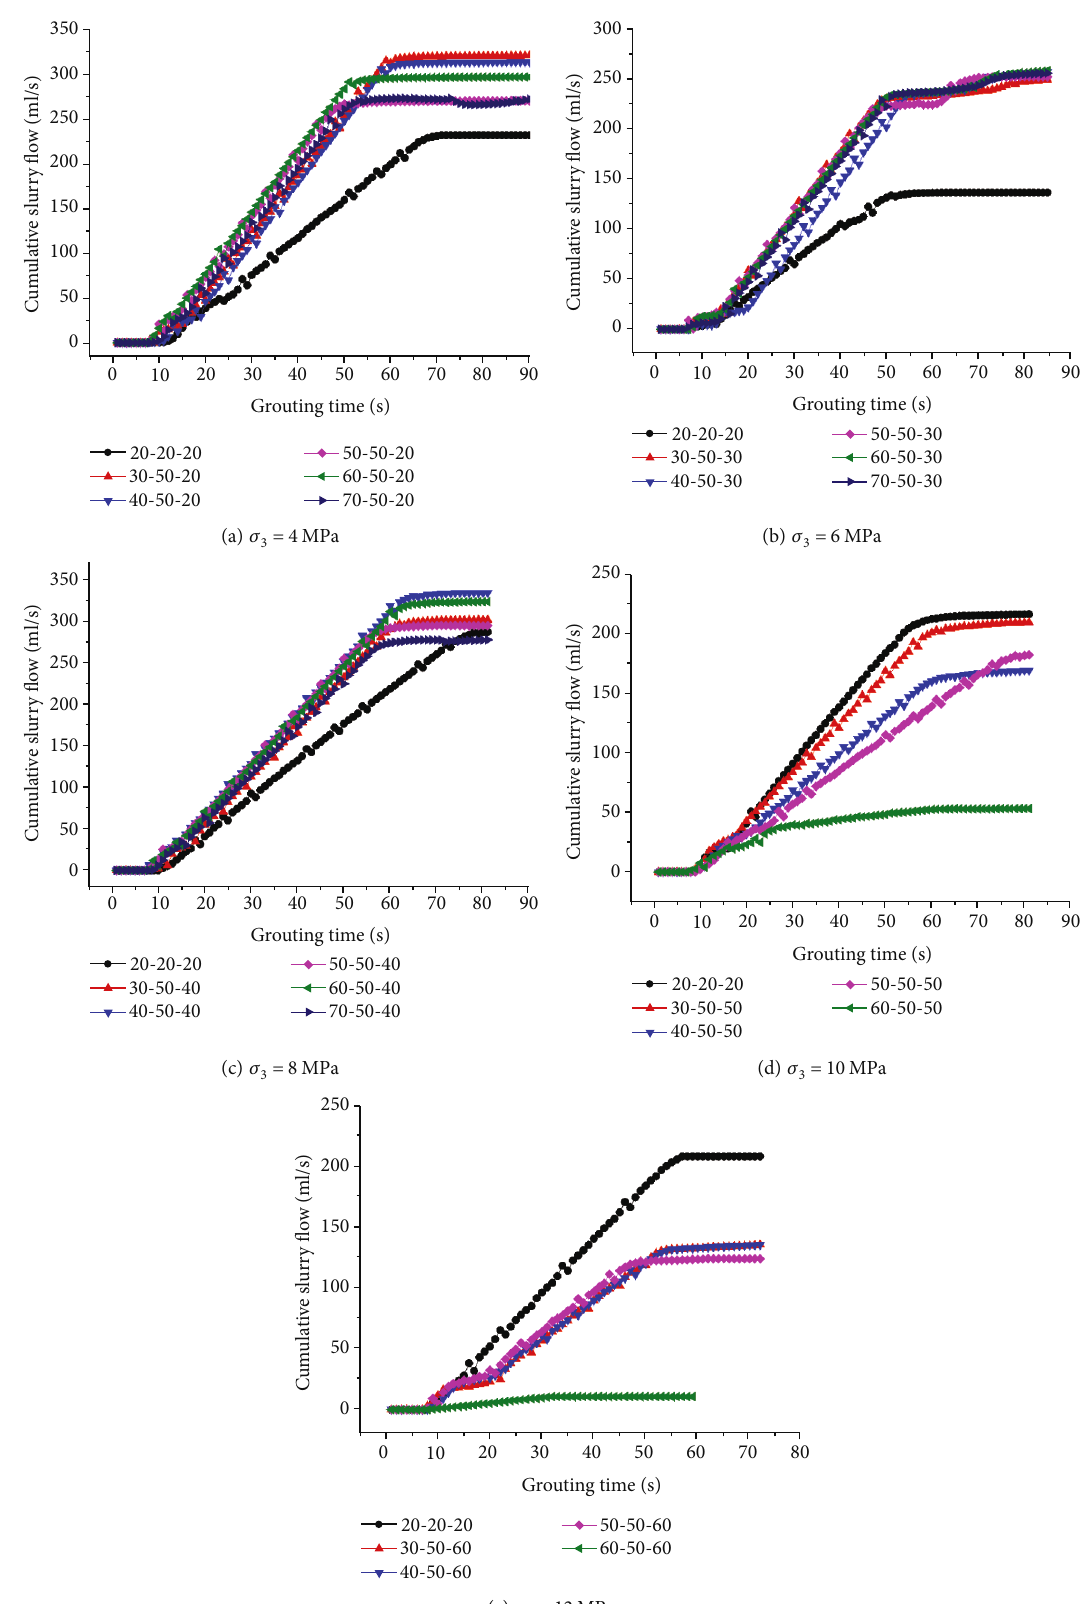
Figure 14: Cumulative fl ow under di ff erent three-dimensional stress